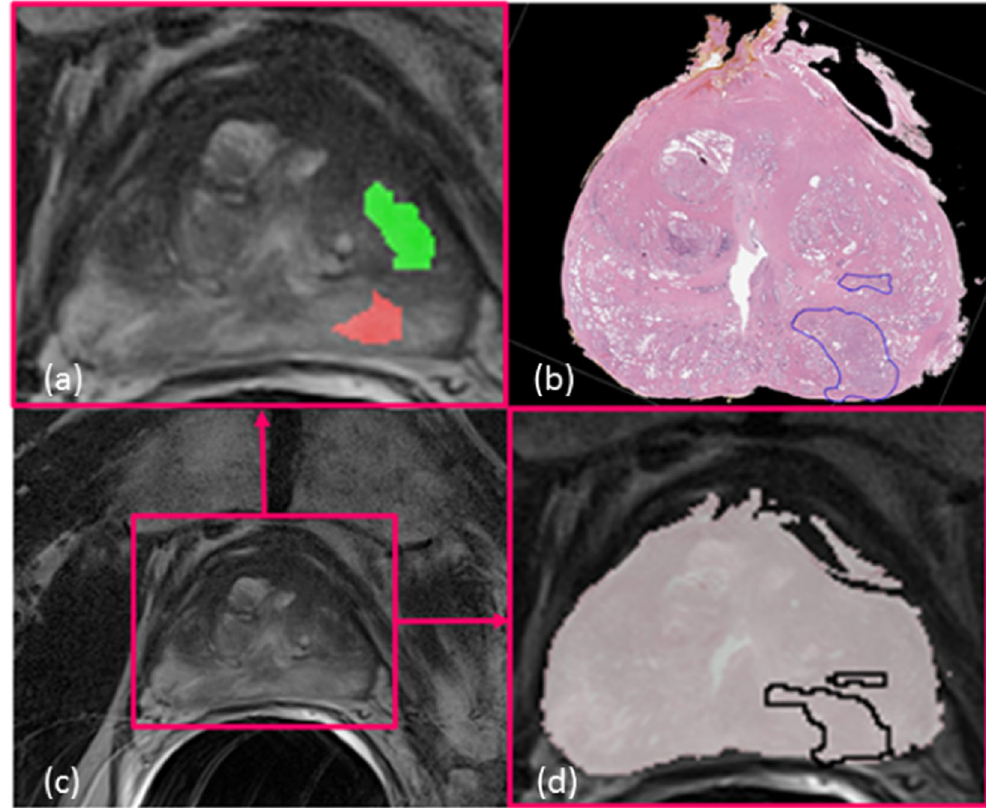
Figure 1. Illustration of a pair of corresponding in vivo prostate MRI ( c ) and ex vivo histology images ( b ). On panel (a) one can observe the cancer annotations made by two radiologists (green and red) unblinded to the corresponding histology images. The divergent annotations made by the two radiology readers, in spite of having access to the pathology images, suggests the need for accurate co-registration of pathology and radiology imaging in order to ascertain the ground truth extent for disease on radiology imaging (( d ) the overlap registration